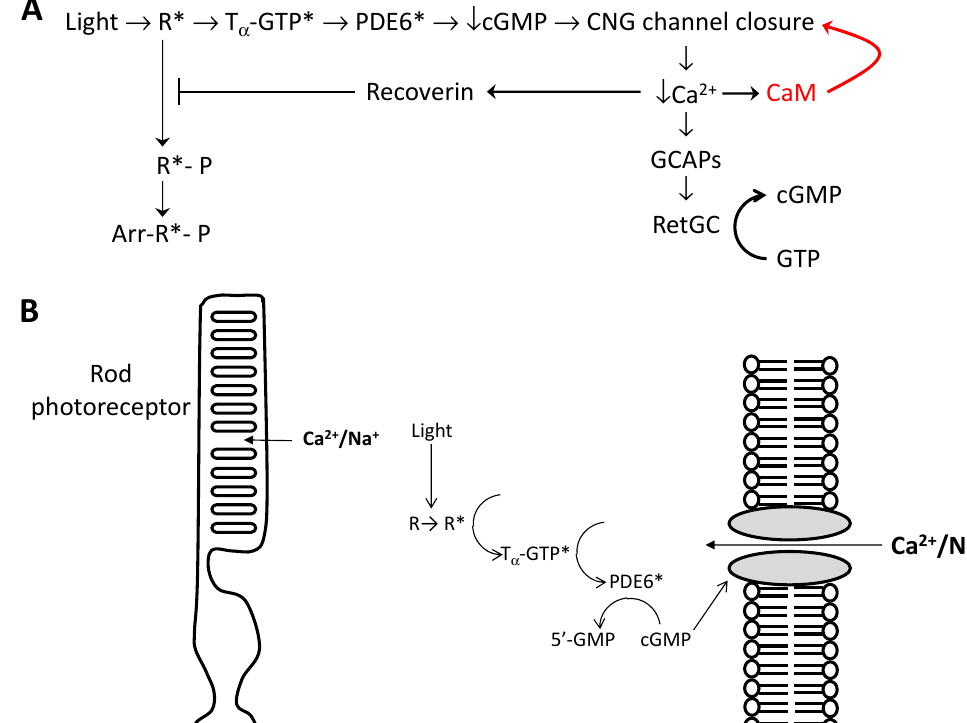
Figure 2. CNG channel function in visual phototransduction. ( A ) Schematic model of visual excitation regulated by intracellular Ca 2+ : Light-excited rhodopsin (R*), GTP-bound transducin (T α -GTP), phosphodiesterase (PDE6), retinal guanylate cyclase (RetGC), guanylate cyclase activating proteins (GCAPs), phosphorylated rhodopsin (R*-P), arrestin (Arr). ( B ) CNG channel gating by intracellular cGMP in the plasma membrane of rod photoreceptors.